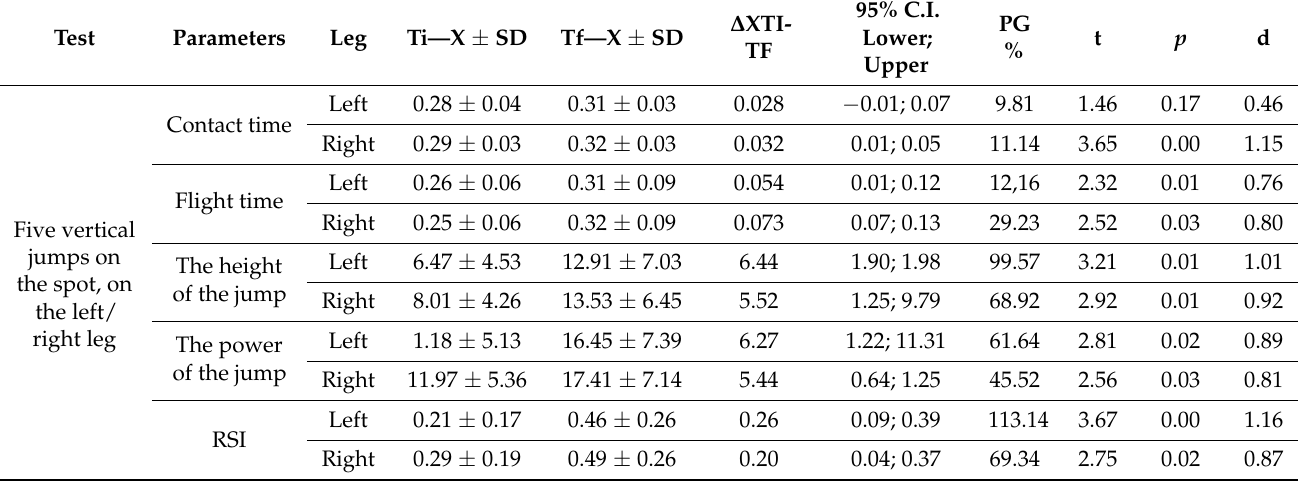
Table 1. Statistical description of the test of five vertical jumps on the spot, on the left/right leg.